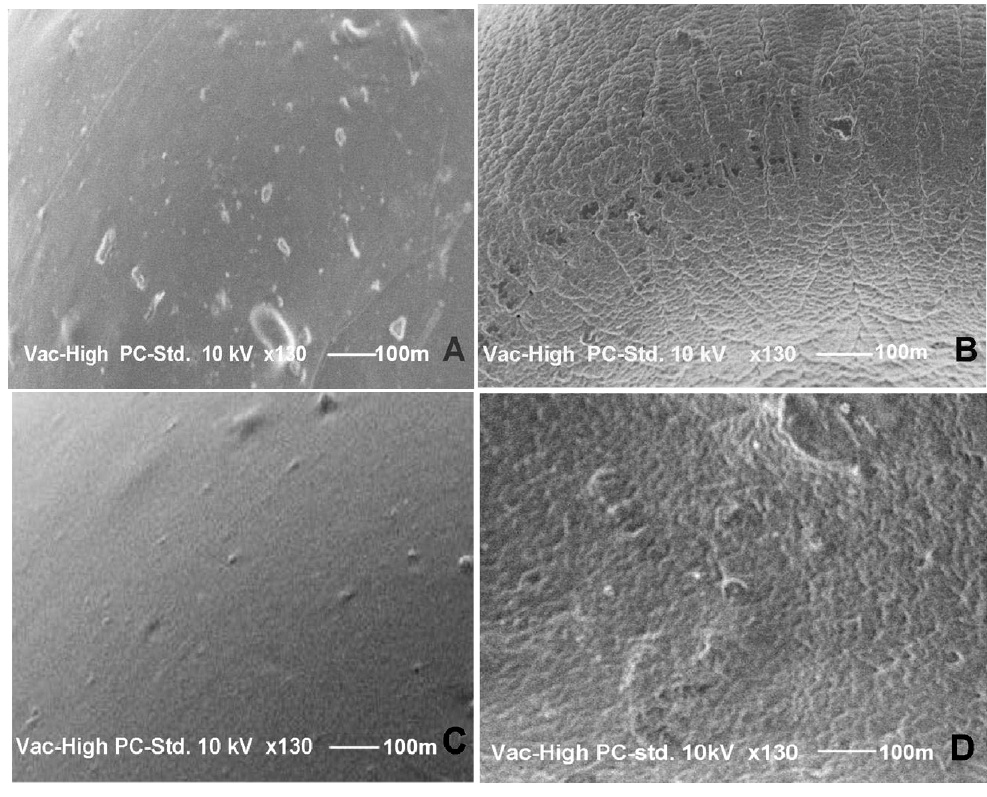
Figure 2. SEM of the pectinate bead surfaces (130 × magnification). ( A ) MSKE-free zinc-pectinate bead; ( B ) MSKE-loaded zinc-pectinate bead; ( C ) MSKE-free calcium-pectinate bead; ( D ) MSKE-loaded calcium-pectinate